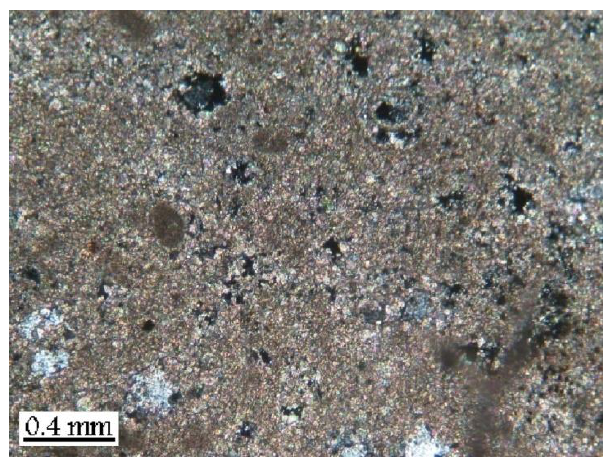
Figure 5. Microscopic images of marl sediments